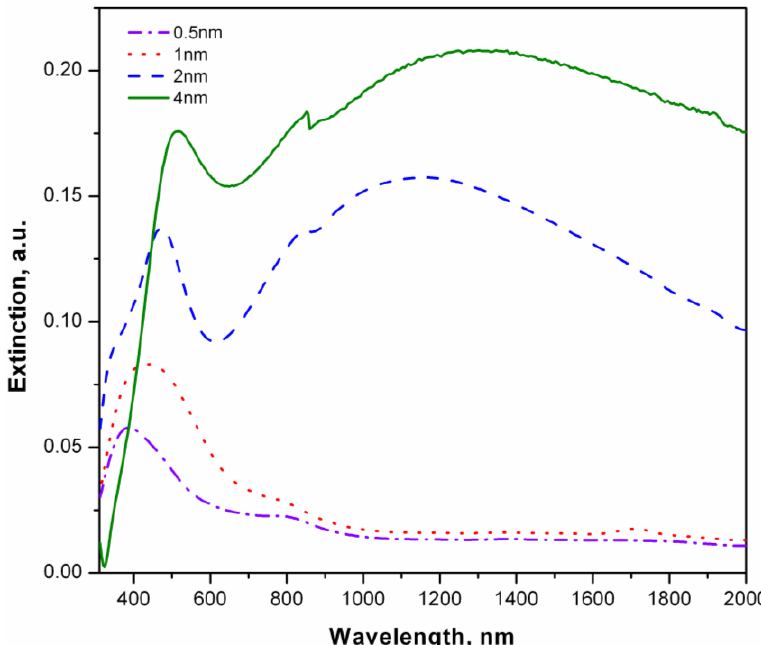
Figure 2. UV-Vis spectrum of “polyvinylidene fluoride (PVDF) fiber-Ag composite” with increasing thickness of silver coat (0.5 to 4